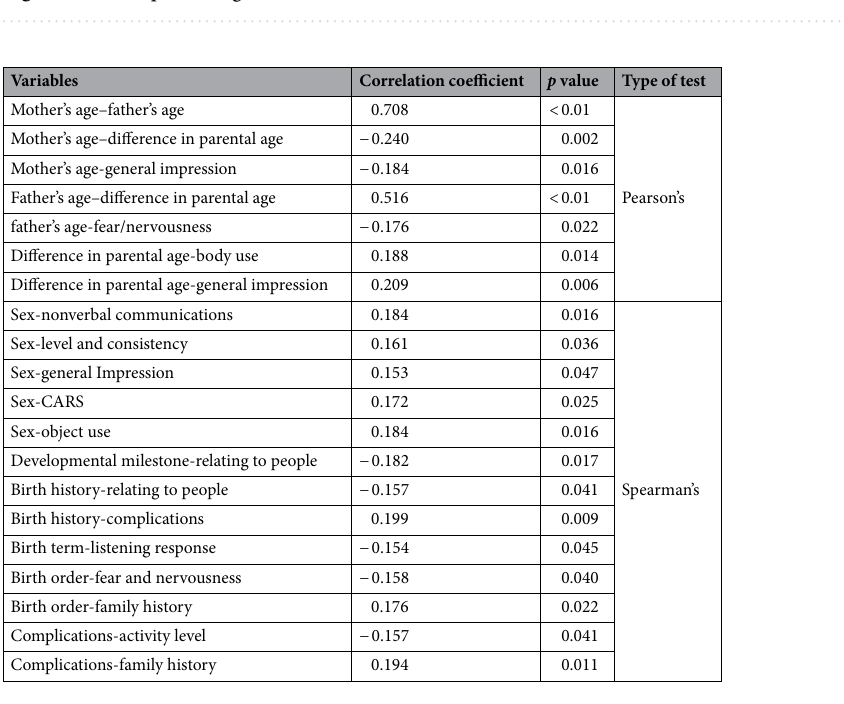
Figure 1. Scree plot of Eigen values for the data set.